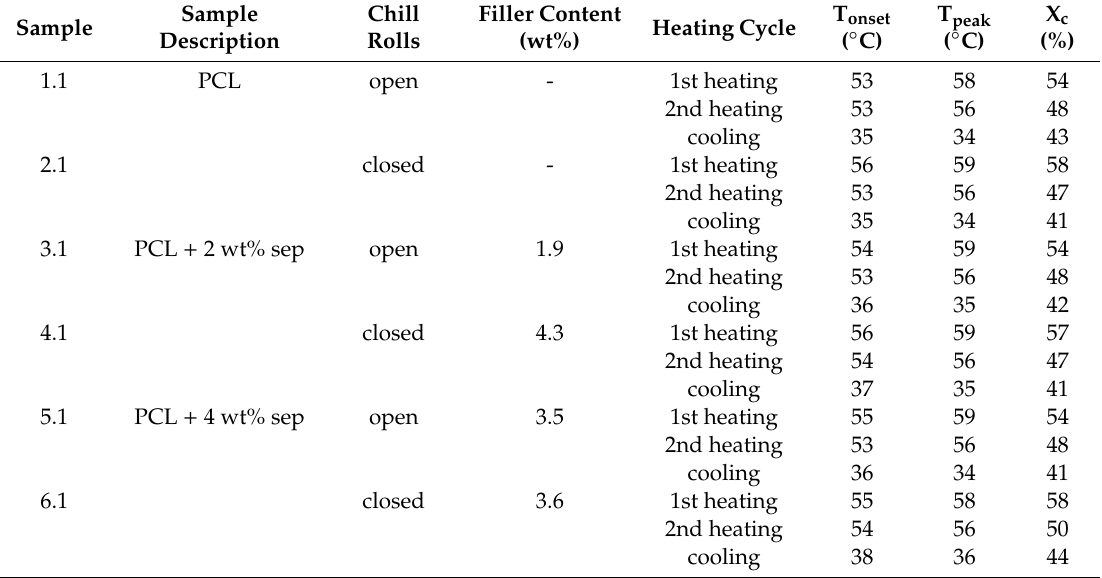
Table A2. Data obtained from DSC experiments of as-extruded film samples.